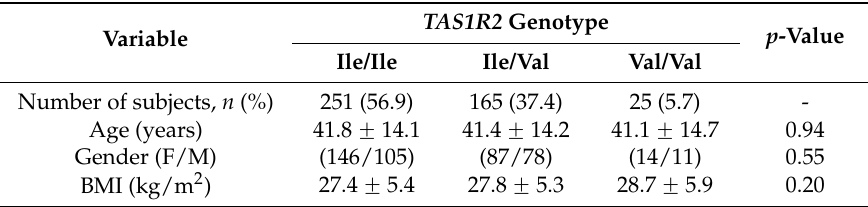
Table 1. Comparison of the subject characteristics by TAS1R2 genotype ( n = 441).